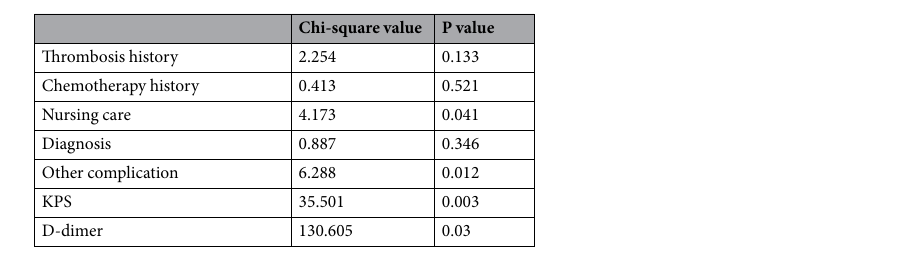
Table 2. The multivariable logistic regression test of the risk factors of PICC related thrombosis.